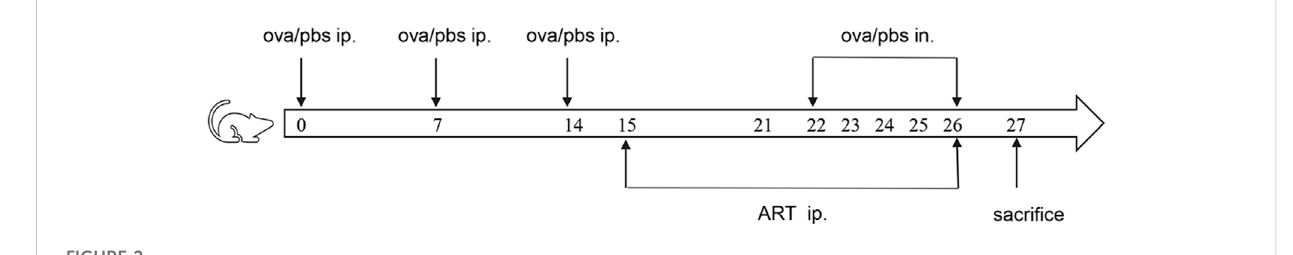
FIGURE 2 The establishment of mouse asthma